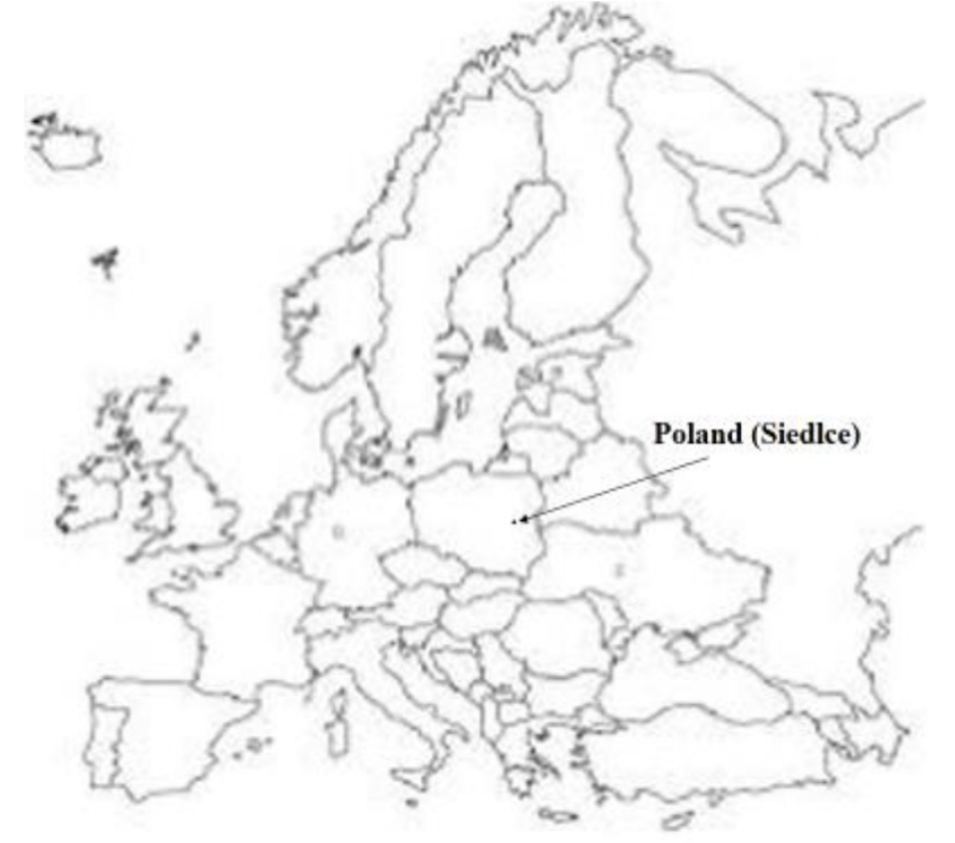
Figure 1. Location of the research site (https://contourmaps.com.pl (accessed on 17 February 2019) as modified by the authors.